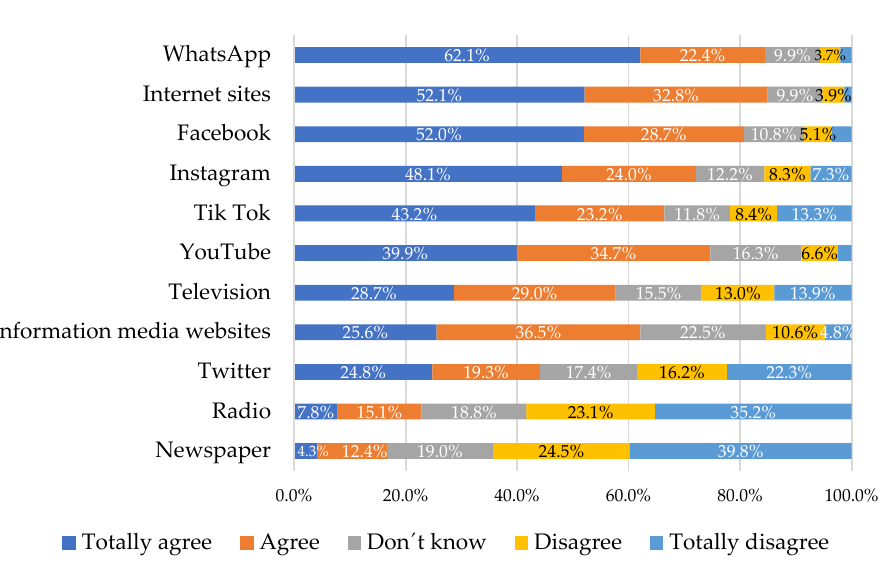
Figure 2. Distribution of percentages of responses to the consumption of information media. 269